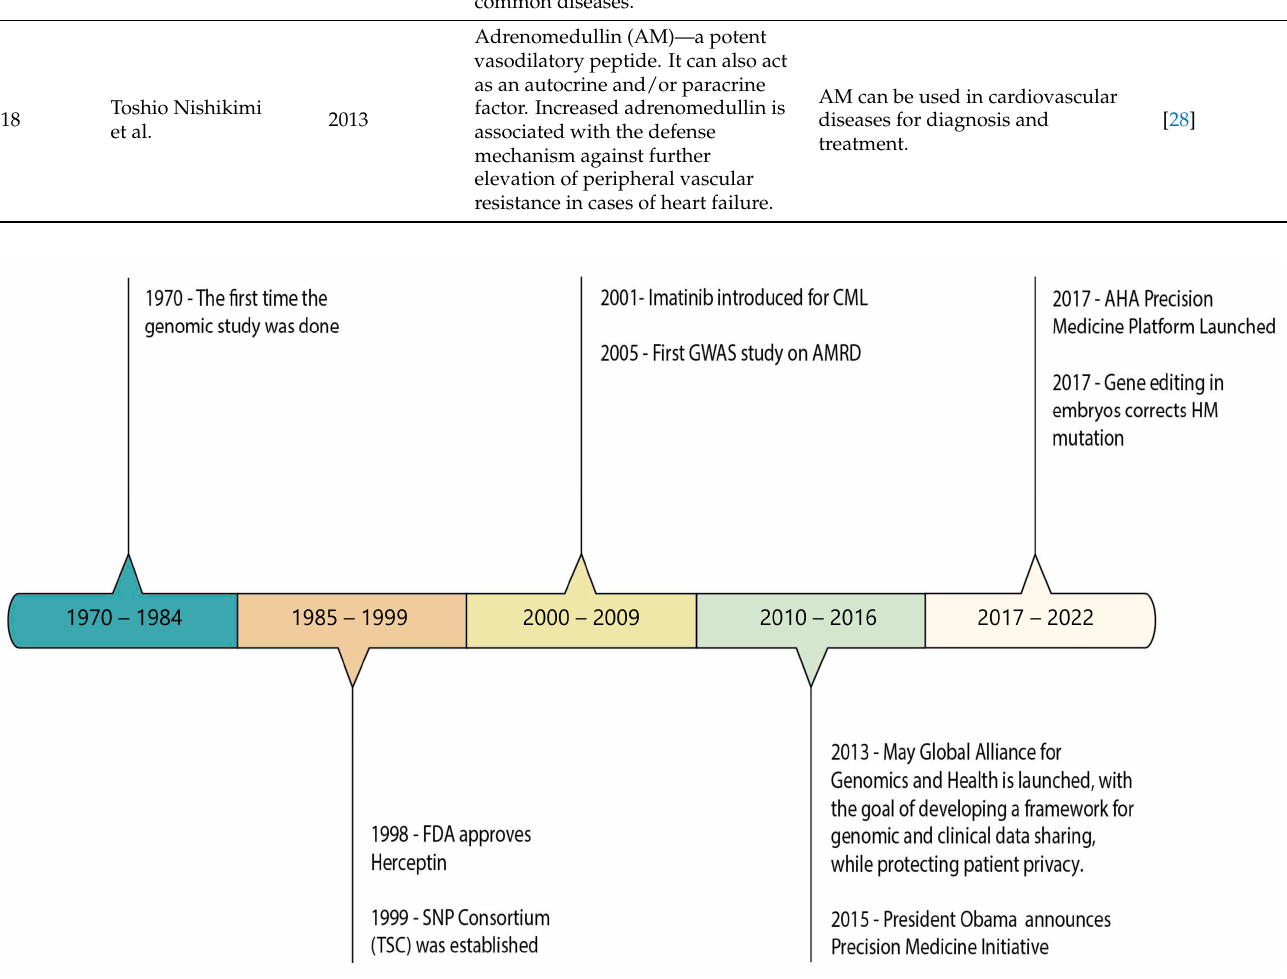
Figure 1. The OMICS in precision medicine.